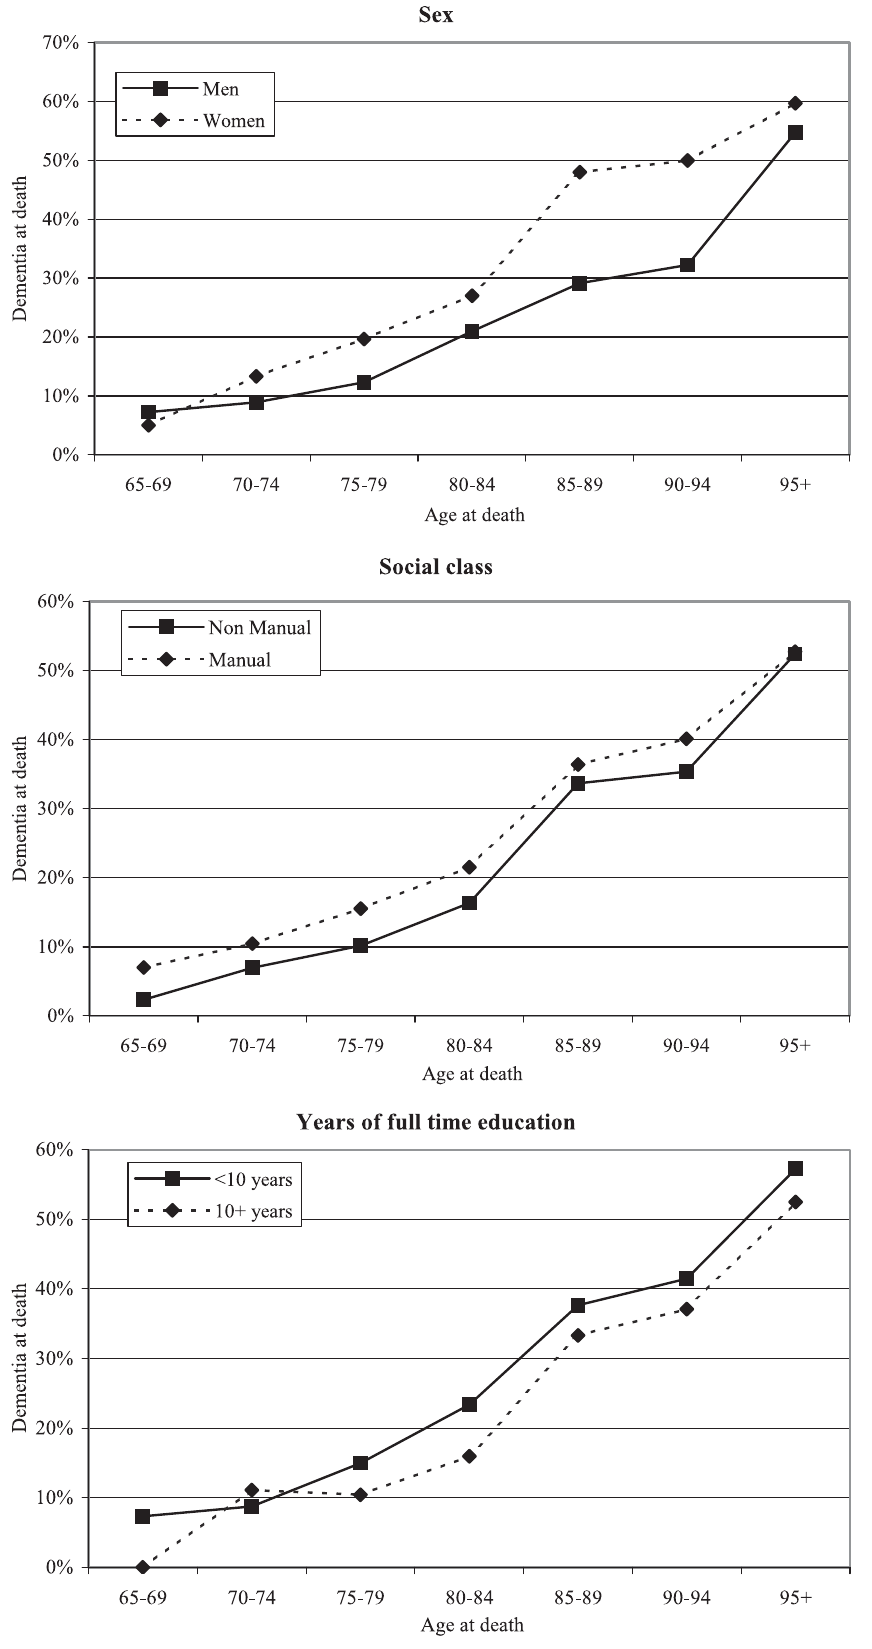
Figure 2. Rate of Dementia at Death by Sex, Education, and Social Class DOI: 10.1371/journal.pmed.0030397.g002 PLoS Medicine | www.plosmedicine.org October 2006 | Volume 3 | Issue 10 |